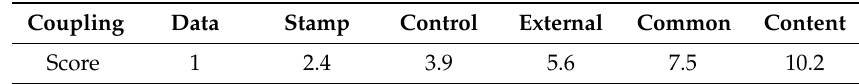
Table 2. The scores for each